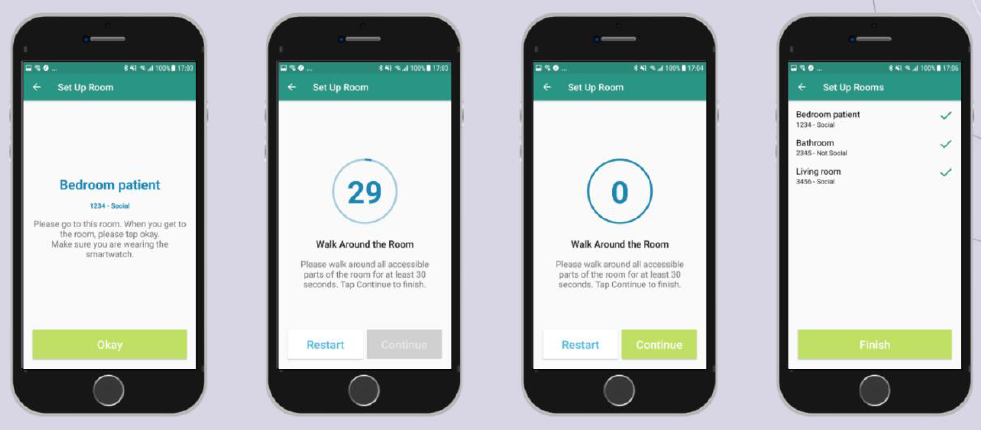
Figure 2. Example screens as shown on the study participant’s smartphone application when performing the experiment of collecting ground truth information during the internal study.